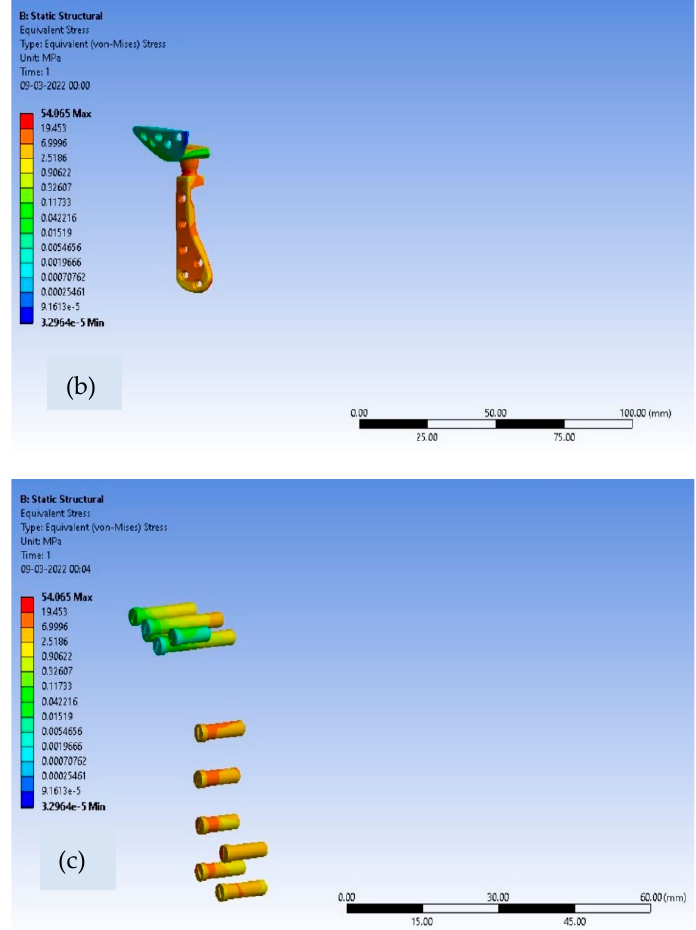
Figure 6. The von-Mises stress contours for ( a ) Total TMJ prostheses with mandible ( b ) Condylar and fossa parts without screws ( c ) fossa and condylar screws in case of Ti-alloy model of customized TMJ prostheses.